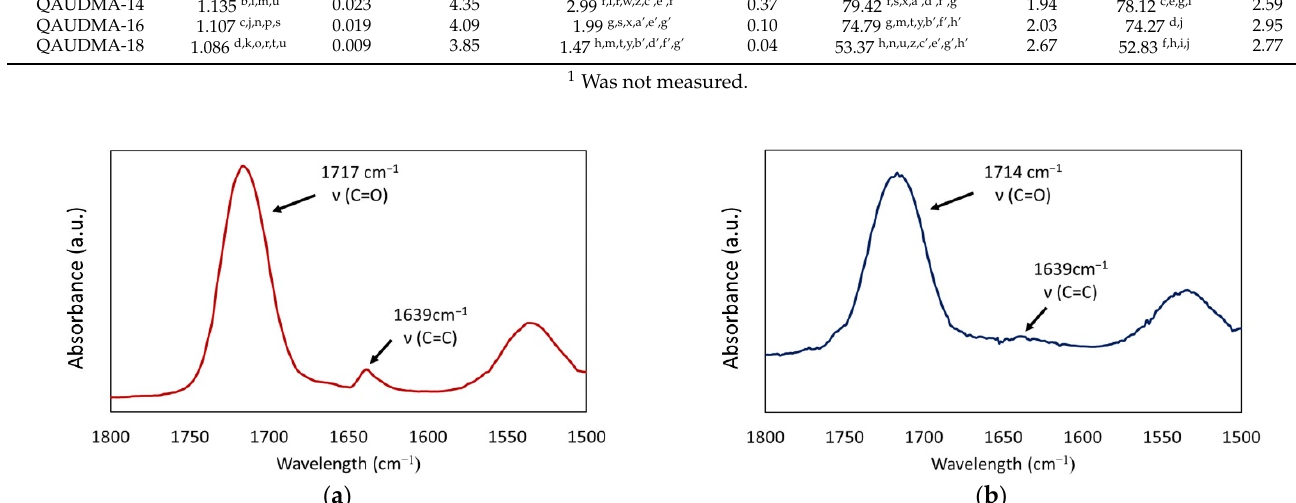
Figure 10. The representative FTIR spectra of the QAUDMA-16 monomer in its uncured ( a ) and cured ( b ) forms.